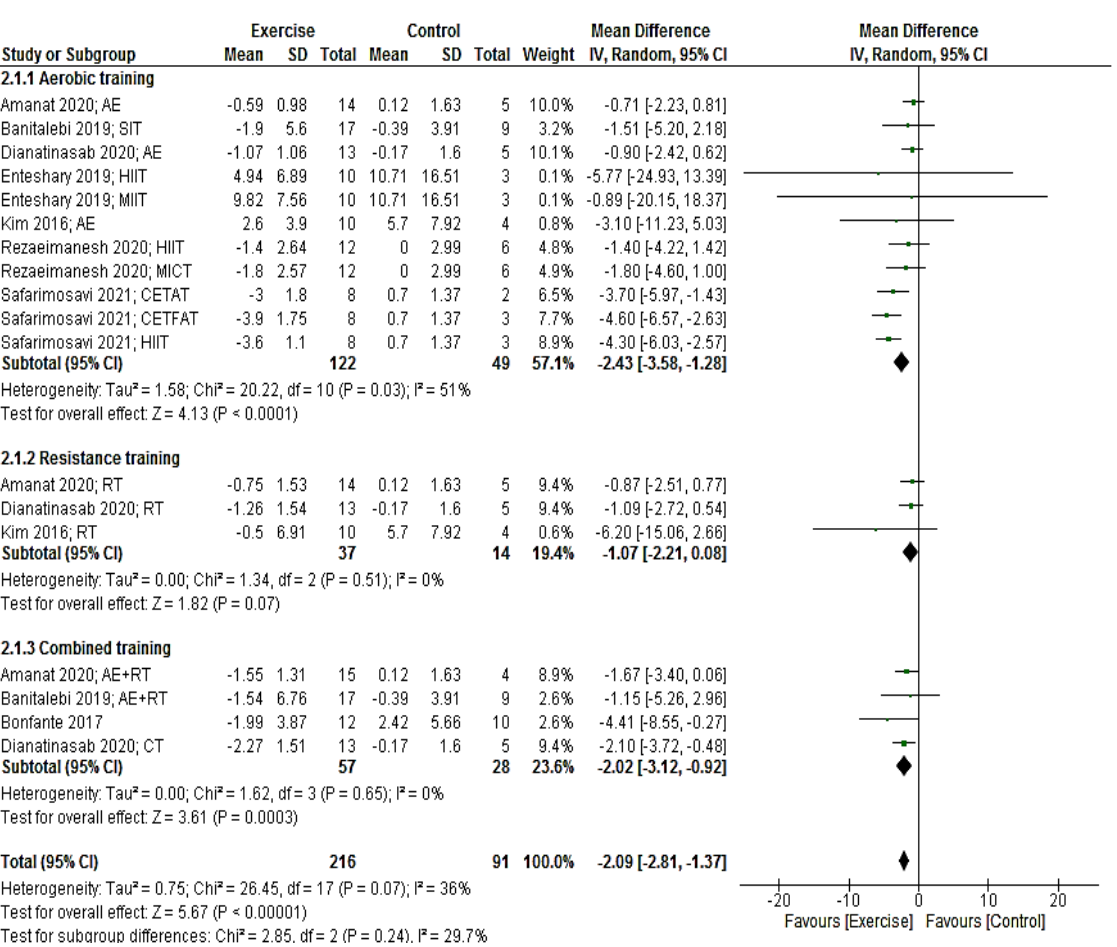
Figure 3: Forest plot of the effects of exercise training versus control on insulin. AE, aerobic; RT, re- sistance training; SIT, sprint interval training; HIIT. High intensity interval training; CETFAT, continuous endurance training with intensity equivalent to Fatmax (maximal fat oxidation); CETAT, continuous endurance training with intensity equivalent to anaerobic